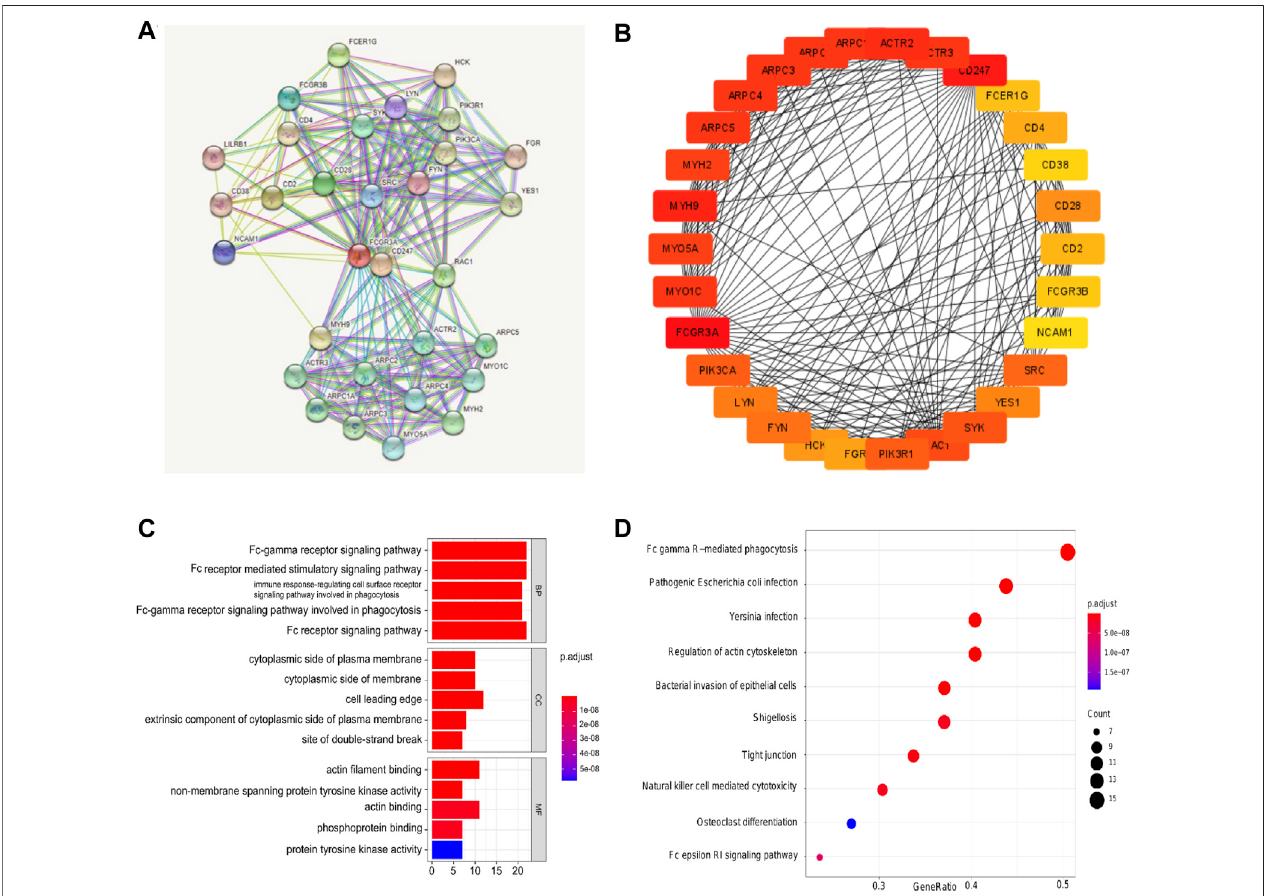
FIGURE 8 | Protein-protein interaction (PPI) network, gene ontology (GO) analysis, and Kyoto Encyclopedia of Genes and Genomes (KEGG) analysis ofFCGR3A- related genes. (A,B) PPI network; (C) GO analyses; (D) KEGG analysis.